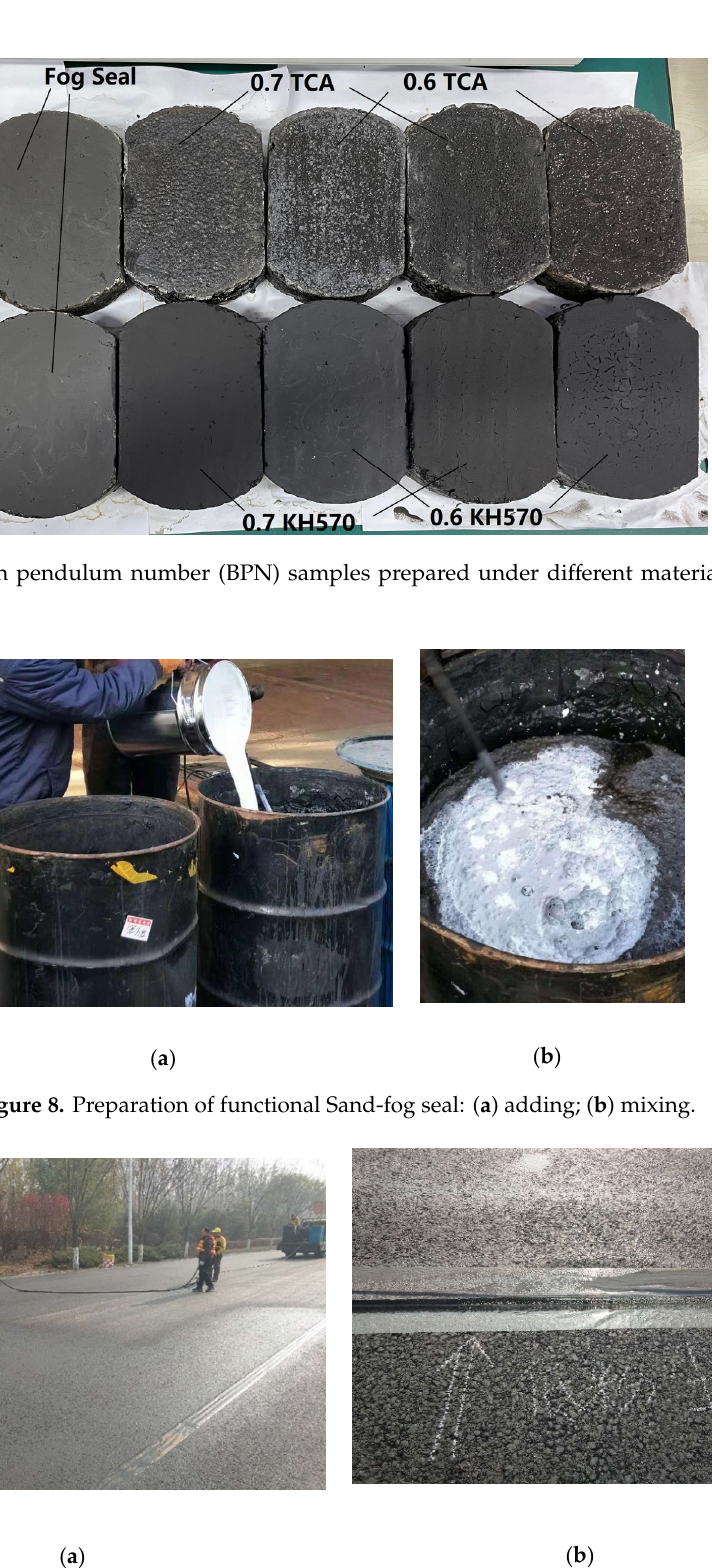
Figure 6. British pendulum tester.